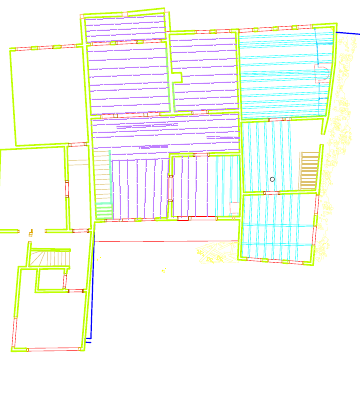
Figure 7. First Floor Structural RCP